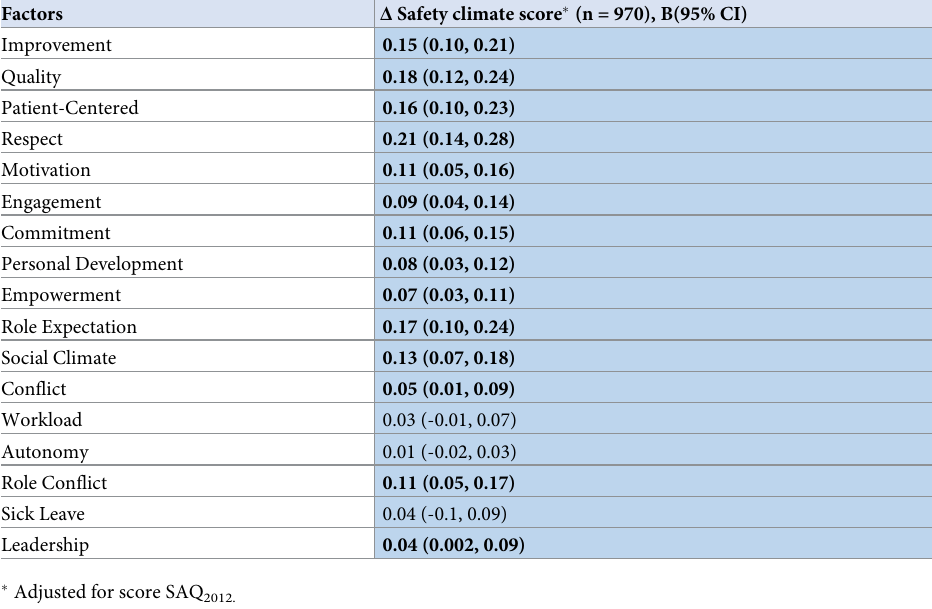
Table 4. Each WES factors univariate association with the change in climate